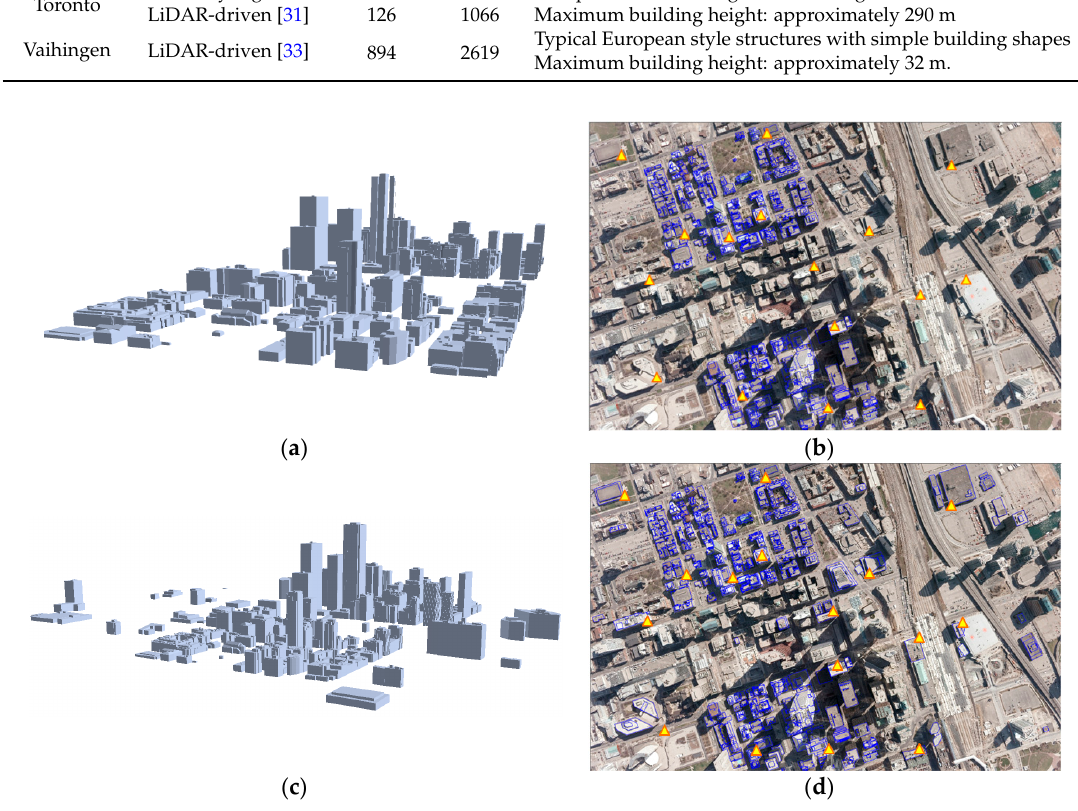
Figure 7. Toronto dataset: ( a ) LiDAR-driven building models reconstructed by [31]; ( b ) LiDAR-driven building models (blue lines) and check points (yellow triangles) back-projected to image; ( c ) manually digitized building models and ( d ) manually digitized building models back-projected to image.